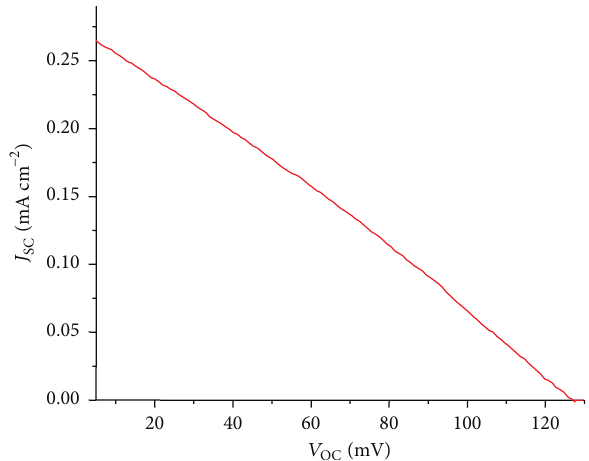
Figure 29: 𝐽𝑉 curve of the p-DSC having ERY-sensitized RDS NiO on ITO as photoactive cathode. NiO film thickness: 0.3 𝜇 m; 𝐼 870 Wm −2